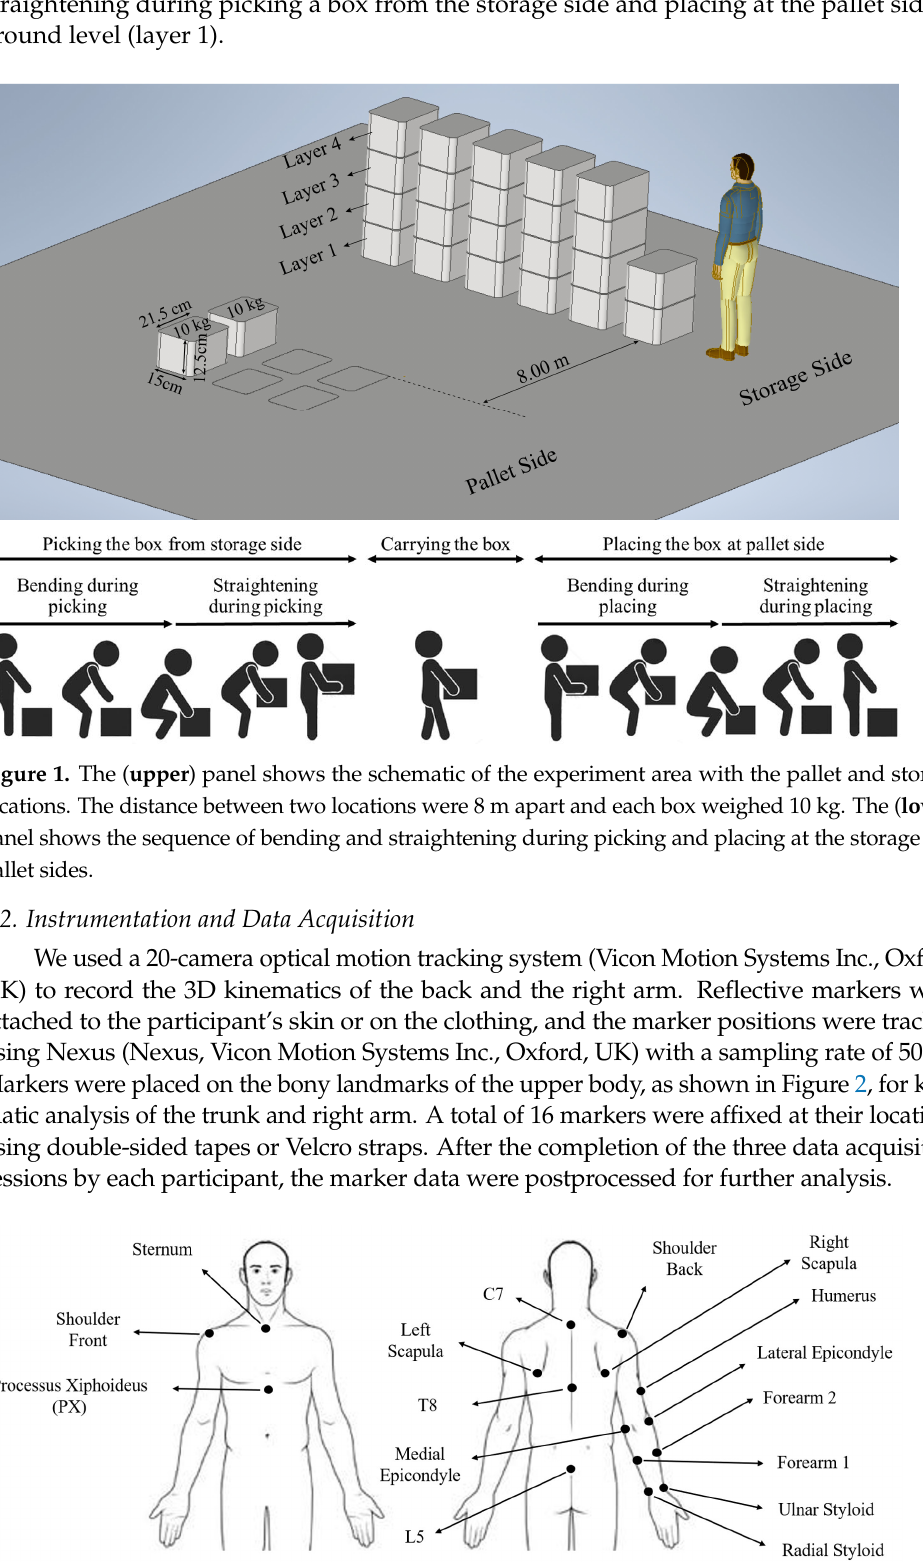
Figure 2. Reflective markers were attached to different locations at the trunk and right arm for kinematic monitoring of the upper